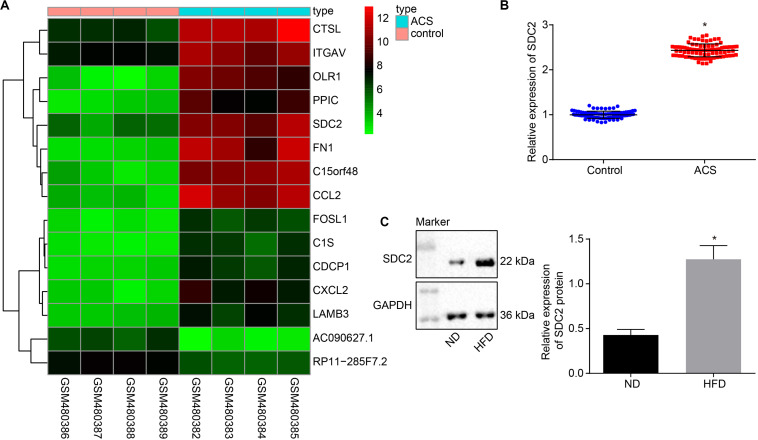
SDC2 is highly-expressed in atherosclerosis. (A) A heatmap of the top 15 DEGs in ACS-related microarray data GSE19339. Abscissa indicates sample number and the ordinate indicates DEGs. Histogram in the upper right refers to color gradation and small squares in the figure represent the expression of a gene in one sample; (B) SDC2 expression patterns determined by RT-qPCR in the PBMCs isolated from patients with ACS (n = 86) and healthy individuals (n = 86), normalized to GAPDH; *p < 0.05 vs. healthy individuals; and (C) Representative Western blots of SDC2 protein and its quantitation in the aortic lysate of HFD-fed ApoE–/– mice (n = 40) and ND-fed ApoE–/– mice (n = 10), normalized to GAPDH; ND refers to ApoE–/– mice fed with normal diet and HFD refers to ApoE–/– mice fed with high-fat diet. *p < 0.05 vs. ND-fed ApoE–/– mice. All data were measurement data and expressed as mean ± standard deviation. Comparisons in panel (B) were analyzed using unpaired t-test, while comparisons in panel C were analyzed using paired t-test.